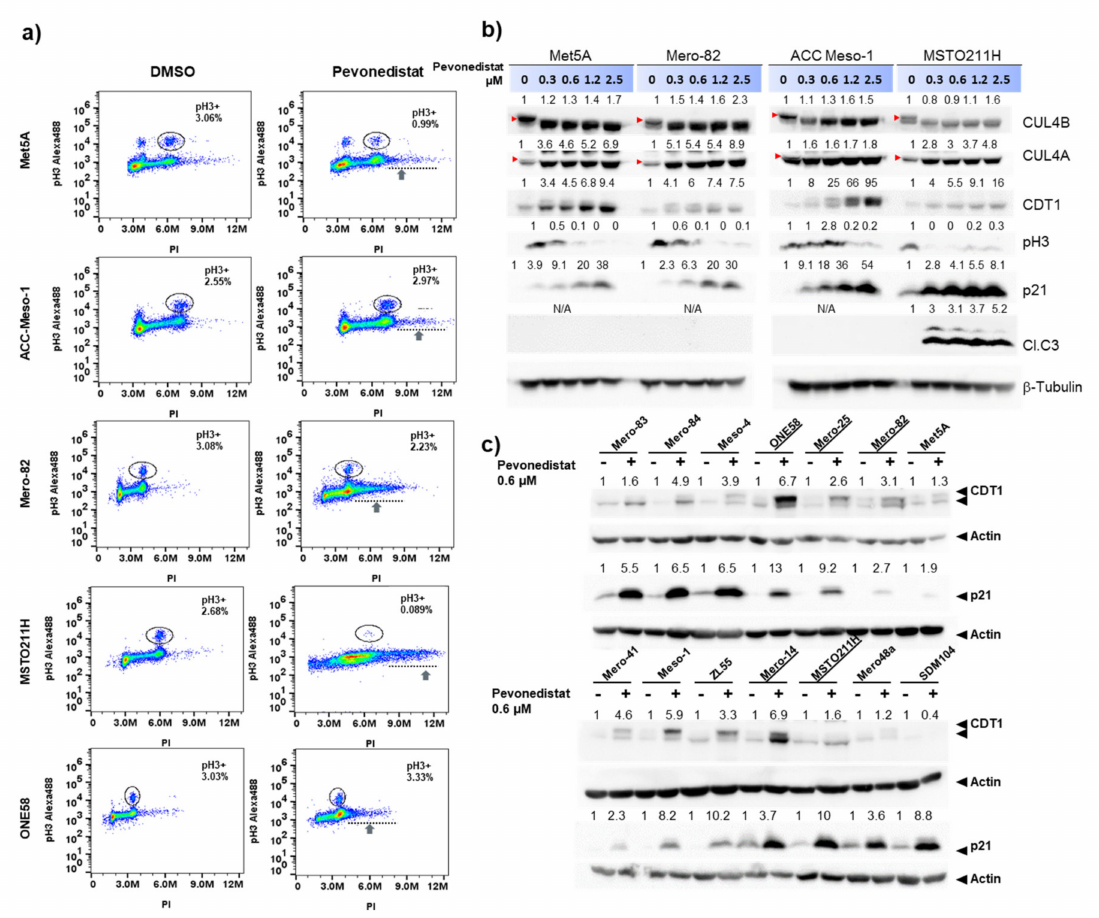
Figure 3. E ff ects of pevonedistat treatment on cell cycle progression, p21 and CDT1 accumulation. ( a ) Cell cycle analysis by double staining with (propidium iodide) PI and pH3 showing an accumulation of cells in the S or G2 phase of the cell cycle predominantly in sensitive cells (Mero-82, MSTO211H and ONE58) treated with 0.3- µ M pevonedistat for 24 h compared to control (treated only with dimethylsulfoxide (DMSO)). We noted a drastically increased accumulation of cells containing > 4N DNA after the treatment, predominantly in the sensitive cell lines, without increased accumulation of cells undergoing mitosis (pH3 + , circles). ( b ) Cells were treated with an increasing concentration of pevonedistat for 24 h and subjected to Western blot analysis for the indicated proteins. Number above each line of the blots represents protein expressions (ratio densitometry of the bands normalized with β -actin) relative to no pevonedistat treatment. Arrows indicate neddylated CUL4A or CUL4B. ( c ) A panel of MPM cell lines treated with DMSO or 0.6- µ M pevonedistat for 24 h shows an accumulation of CDT1 and p21 in both sensitive (underlined) and resistant cell lines. Number above each line of the blots represents protein expressions (ratio densitometry of the bands normalized with β -actin) relative to no pevonedistat